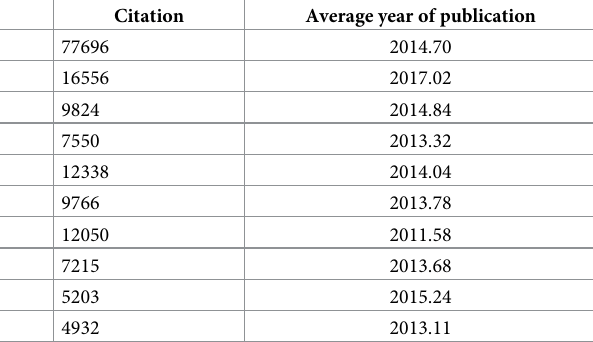
(PJS) (Hemminki A and Jenne DE et al.); cluster #3 (blue), LKB1-AMPK pathway suppresses tumor (Shackelford DB and Ji H et al.); and cluster #4 (yellow), LKB1 related signaling path- ways (Lizcano JM and Alessi DR et al.) (Table 5). Fig 7 displays the major co-references and their clusters.